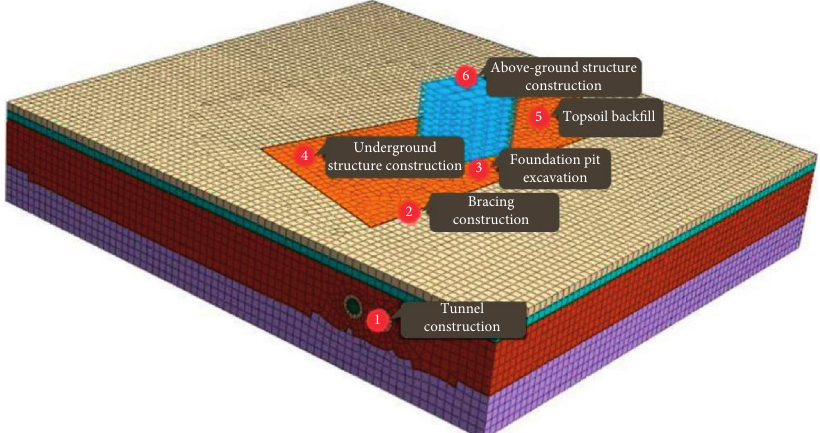
Figure 5: Model construction